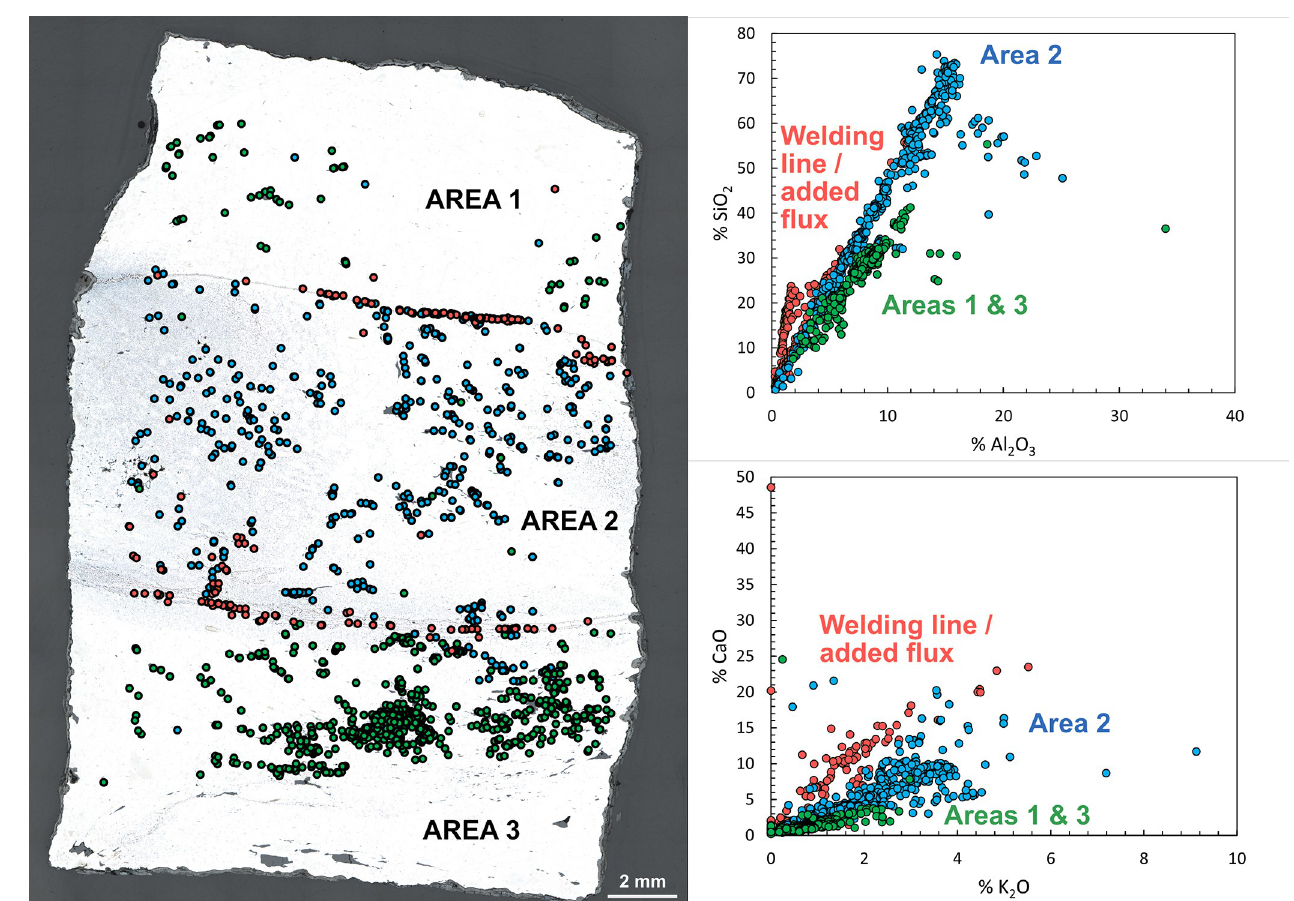
Fig 14. SI composition regarding their location in sample NS7-T. Composition clusters (blue, green, red) were determined by HCA on Xij data. The clusters were then plotted on binary graphs highlighting differences in Al 2 O 3 /SiO 2 and K 2 O/CaO ratios between the clusters.